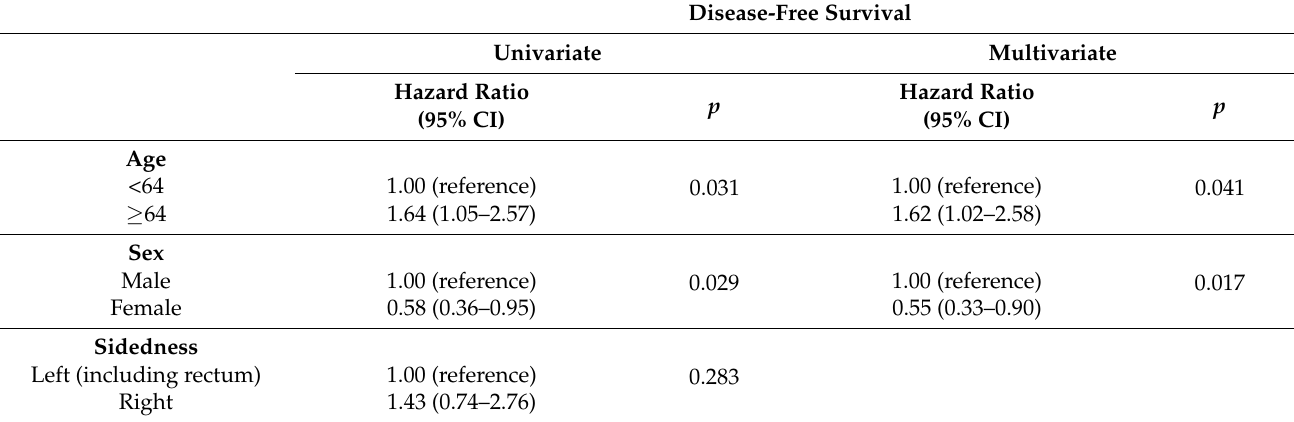
Table 3. Factors associated with disease-free survival on the Cox proportional hazards